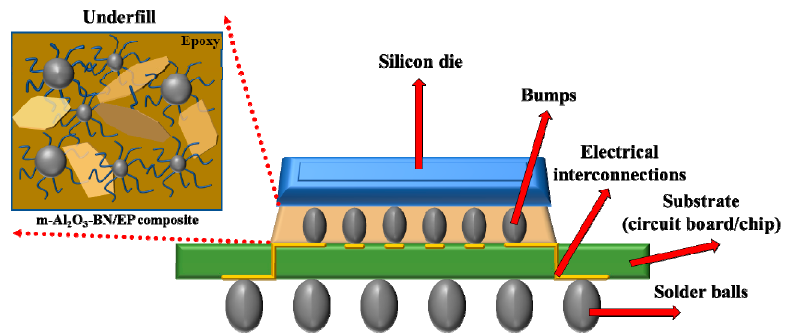
Figure 3. Schematic of the flip-chip underfill packaging.